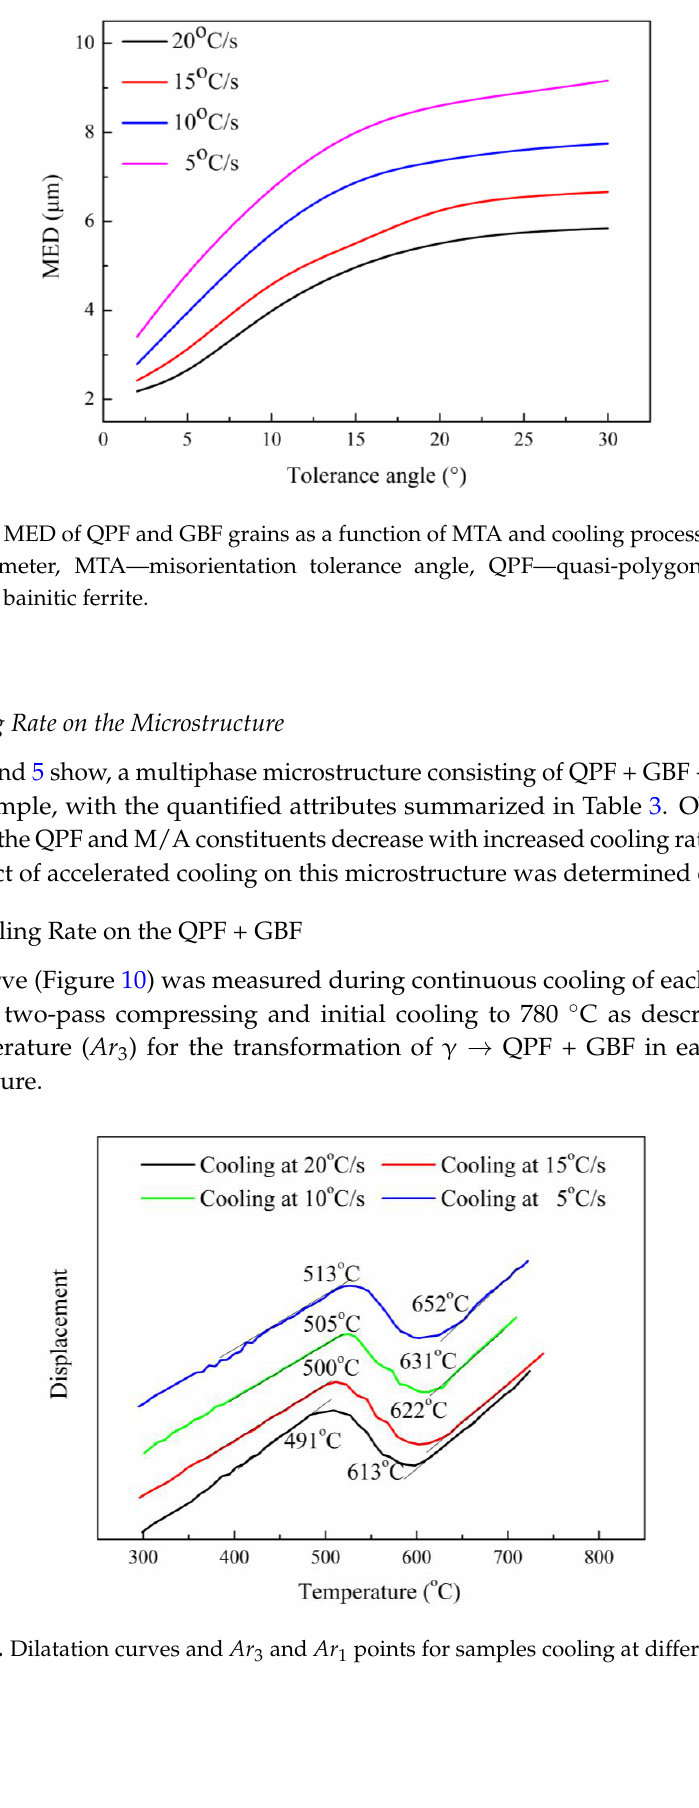
Figure 8. EBSD orientation maps of samples with varied cooling rates: ( a ) 5 °C/s; ( b ) 10 °C/s; ( c ) 15 °C/s; and ( d ) 20 °C/s. The red line and the black line represent the misorientation angle in the range 2°–15° and greater than 15°, respectively.